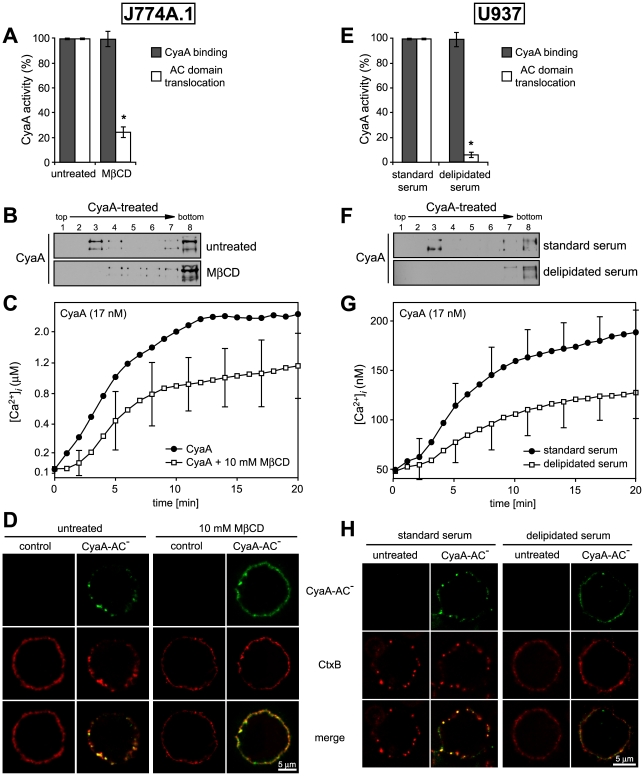
Cholesterol depletion inhibits translocation of AC domain across target cytoplasmic membrane.(A) J774A.1 cells were kept in buffer or treated with 10 mM MβCD at 37°C for 30 min, before CyaA was added for additional 10 min. CyaA binding and AC domain translocation were determined as described in the legend to Fig. 3. Values represent the mean ± S.D. from four independent experiments performed in triplicates. An asterisk indicates a statistically significant difference (*, p<0.01; Student's t test). (B) J774A.1 cells were kept in buffer or pretreated with 10 mM MβCD at 37°C for 30 min and incubated with 1 nM CyaA for 10 min. Cell lyzates were analyzed as in Fig. 1A. (C) J774A.1 cells were loaded with the Ca2+ probe Fura-2/AM prior to cholesterol extraction with 10 mM MβCD at 30°C for 30 min. CyaA-mediated Ca2+ influx was recorded as above. Standard deviations were calculated for mean values at indicated time points and the shown curves are representative of at least three independent experiments. (D) J774A.1 cells grown on coverslips were kept in buffer or pretreated with 10 mM MβCD at 37°C for 30 min. Membrane distribution of fluorescently labeled CyaA-AC− (6 nM, green) and CtxB (5 µg/ml, red) was visualized as described in the legend to Fig. 2. (E) U937 cells were grown for 48 hours in RPMI medium supplemented with 10% fetal calf serum (standard serum) or with 10% lipoprotein-deficient serum from fetal calf (delipidated serum). CyaA binding and AC domain translocation were determined as described in the legend to Fig. 3. Values represent the mean ± S.D. from four independent experiments performed in triplicates. An asterisk indicates a statistically significant difference (*, p<0.01; Student's t test). (F) U937 cells grown in standard or delipidated serum were incubated with 1 nM CyaA at 37°C for 10 min, cell lyzates were separated on sucrose density gradients and analyzed as in Fig. 1. (G) U937 cells grown in standard or delipidated serum were loaded with the Ca2+ probe Fura-2/AM (3 µM) at 25°C for 30 min, exposed to CyaA (17 nM) and the time course of Ca2+ entry was recorded as above. Standard deviations were calculated for mean values at indicated time points and the shown curves are representative of at least three independent experiments. (H) U937 cells cultured with standard or delipidated serum were mounted on polylysin-coated coverslips and membrane distribution of fluorescently labeled CyaA-AC− (6 nM, green) and CtxB (5 µg/ml, red) was visualized as described above.